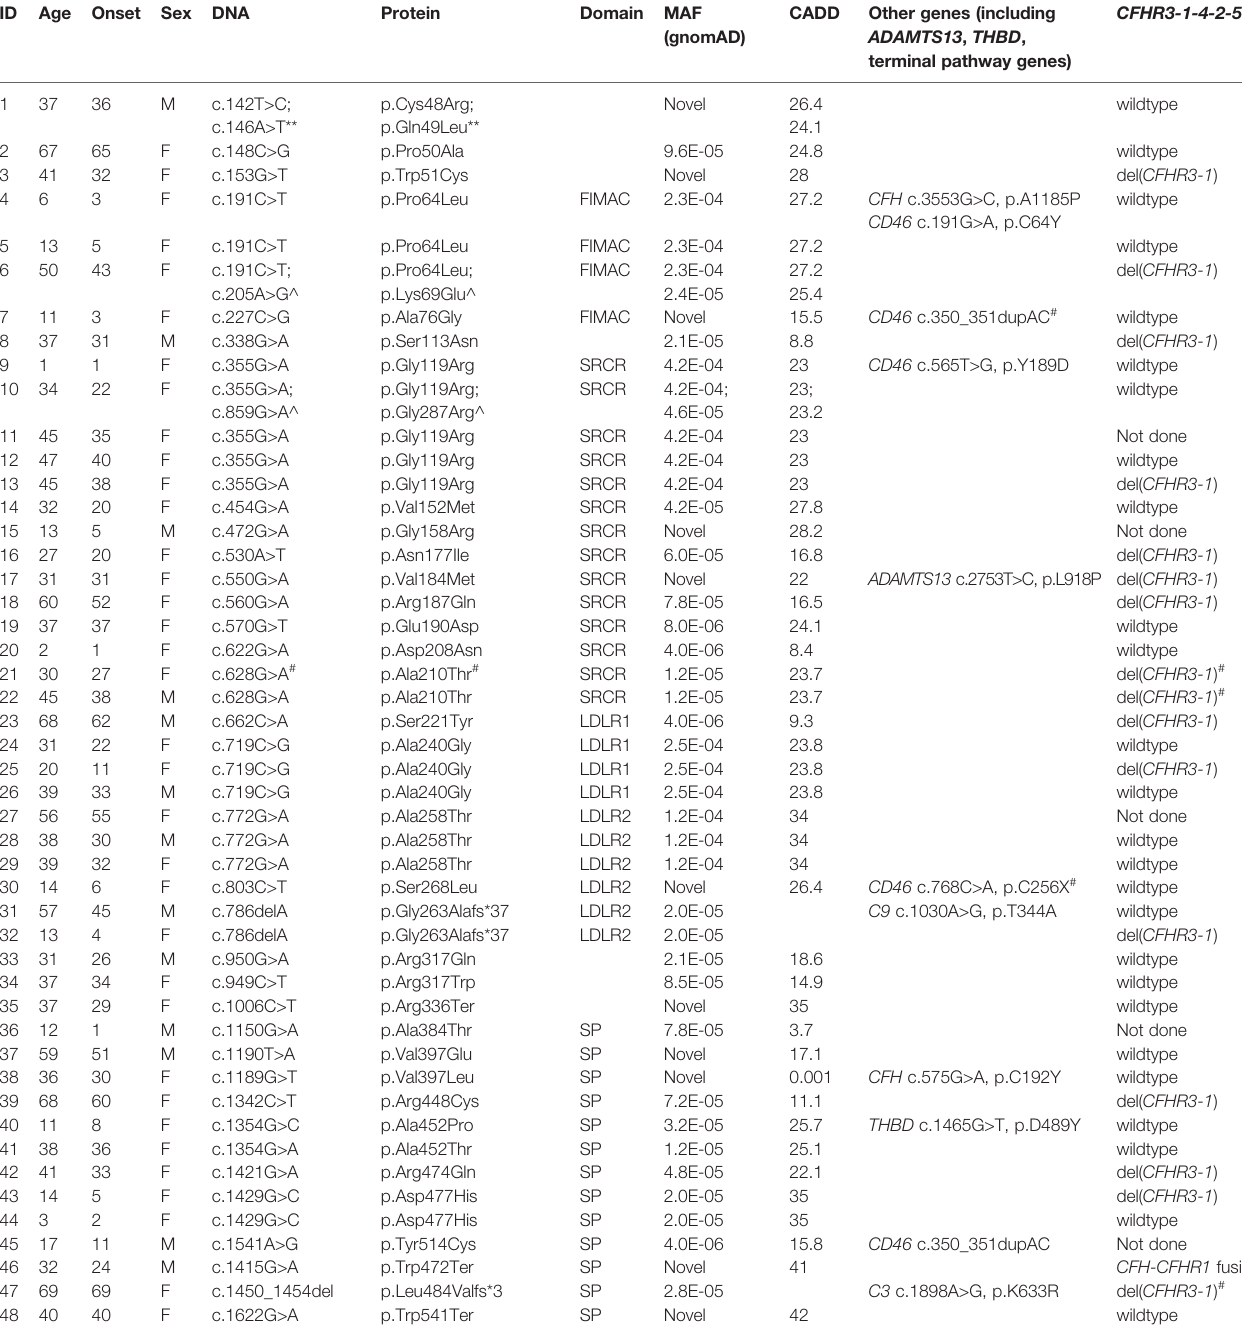
TABLE 2 | Demographic and genetic data in patients with